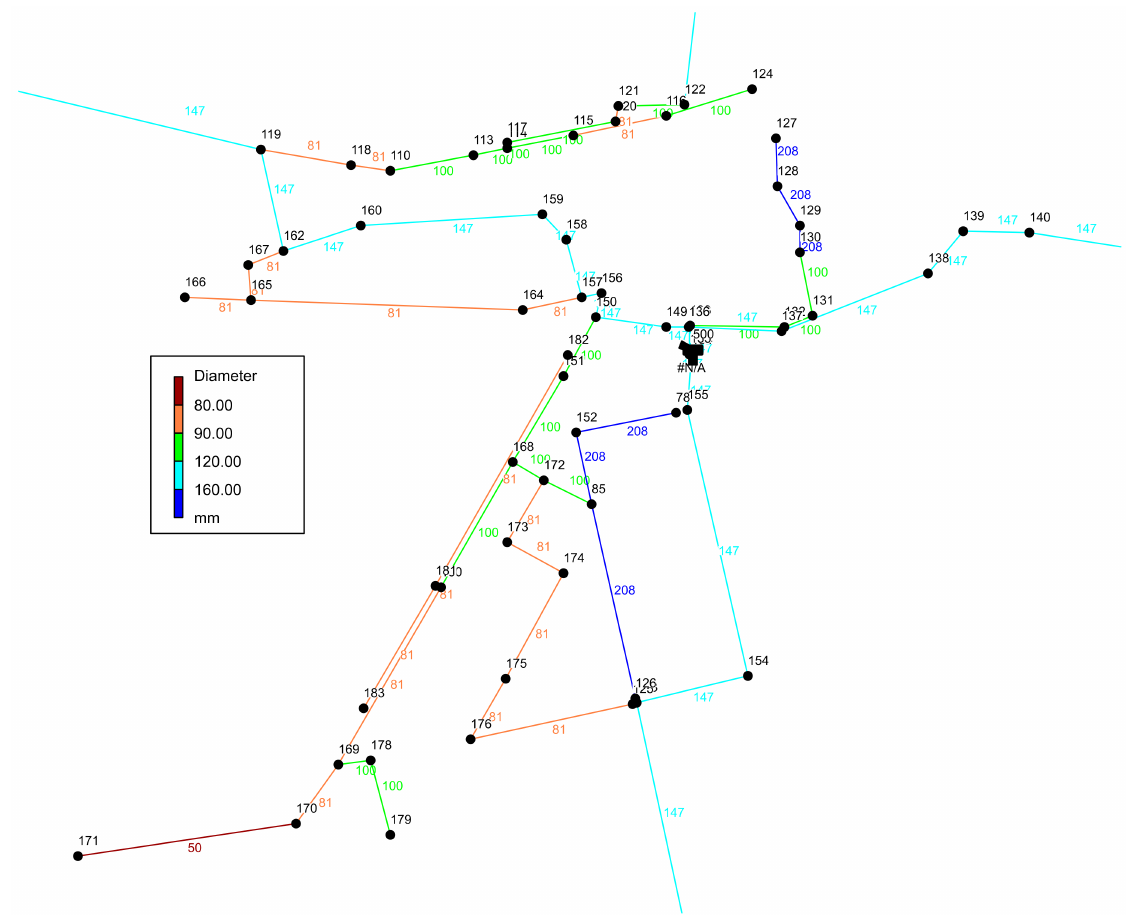
Figure 9. The diameters for the central part of the network, near the water tank. The third analysed variant of network operation took into account increased tank capacity and the efficiency of the pumping system connected to it. A water supply tank with a capacity twice as large as the current one (200 m 3 ) was adopted. The pumping system efficiency was increased to ca. 65 m 3 /h at a pumping height of 52 mH 2 O. Since water supply problems occurred at maximum water demands during previous simulations, they were also taken into account in this variant of the analysis. If these water supply parameters are accepted, the simulation runs correctly, and the program does not report an error message. However, in this case, high values of available pressure were found in previously observed areas of the network with a shortage in other network nodes (a decrease below 20 mH 2 O). Figure 10 shows simulated pressure values in individual nodes and water flow for this part of the network, where the biggest problems with water supply occurred. The same colour scheme was used to present the values of individual parameters as